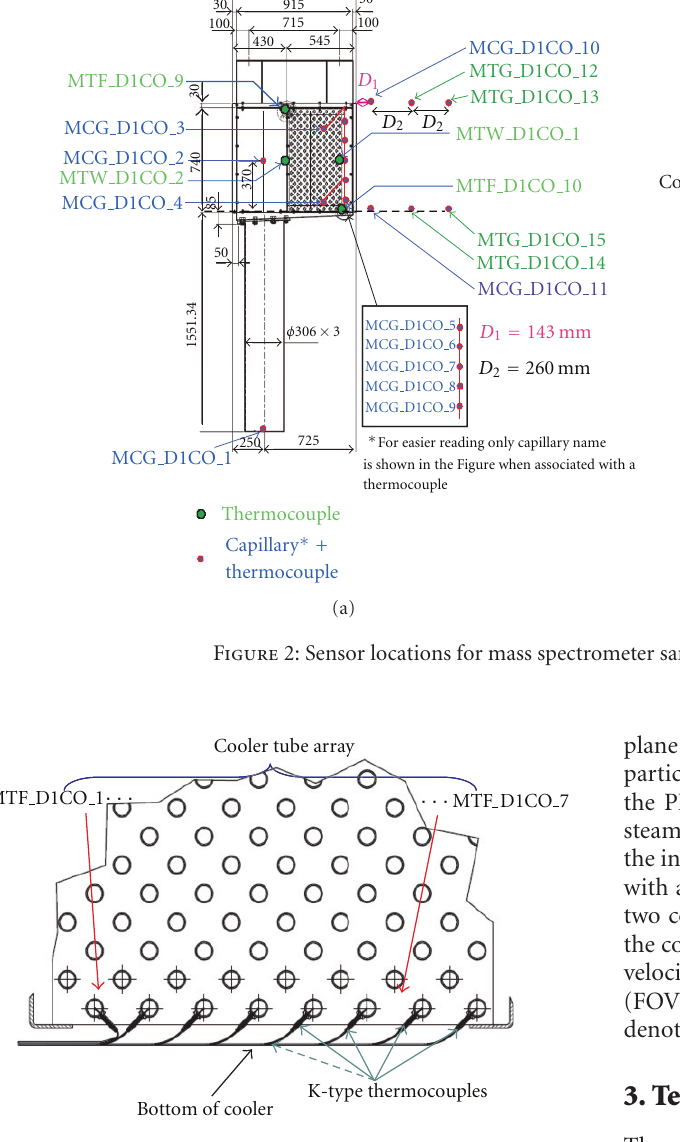
Figure 3: Schematic of the installed TCs in the cooler outlet sub-